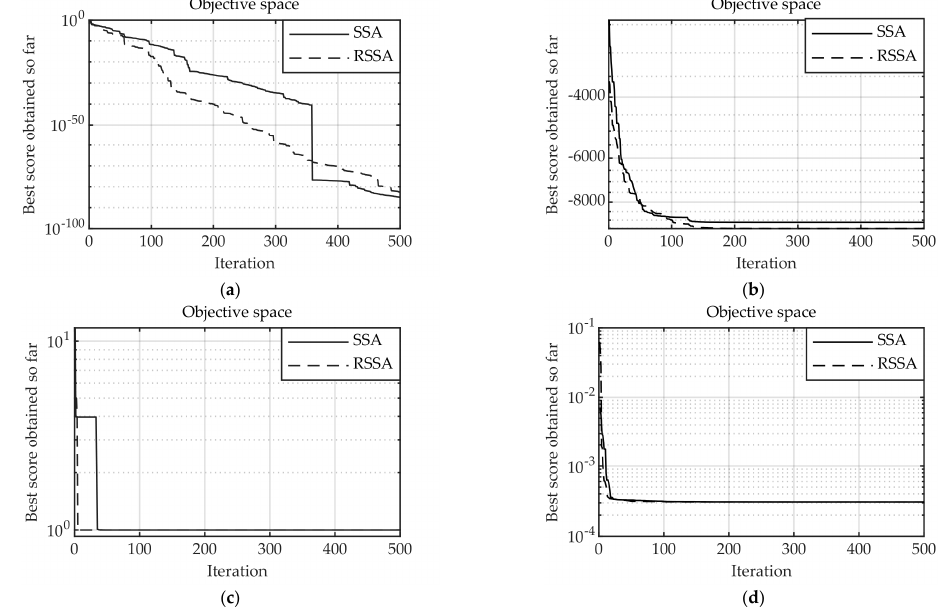
Figure 7. Convergence comparison between SSA and RSSA: ( a ) 𝑓 (cid:2869) ; ( b ) 𝑓 (cid:2876) ; ( c ) 𝑓 (cid:2869)(cid:2872) ; ( d ) 𝑓 (cid:2869)(cid:2873) .